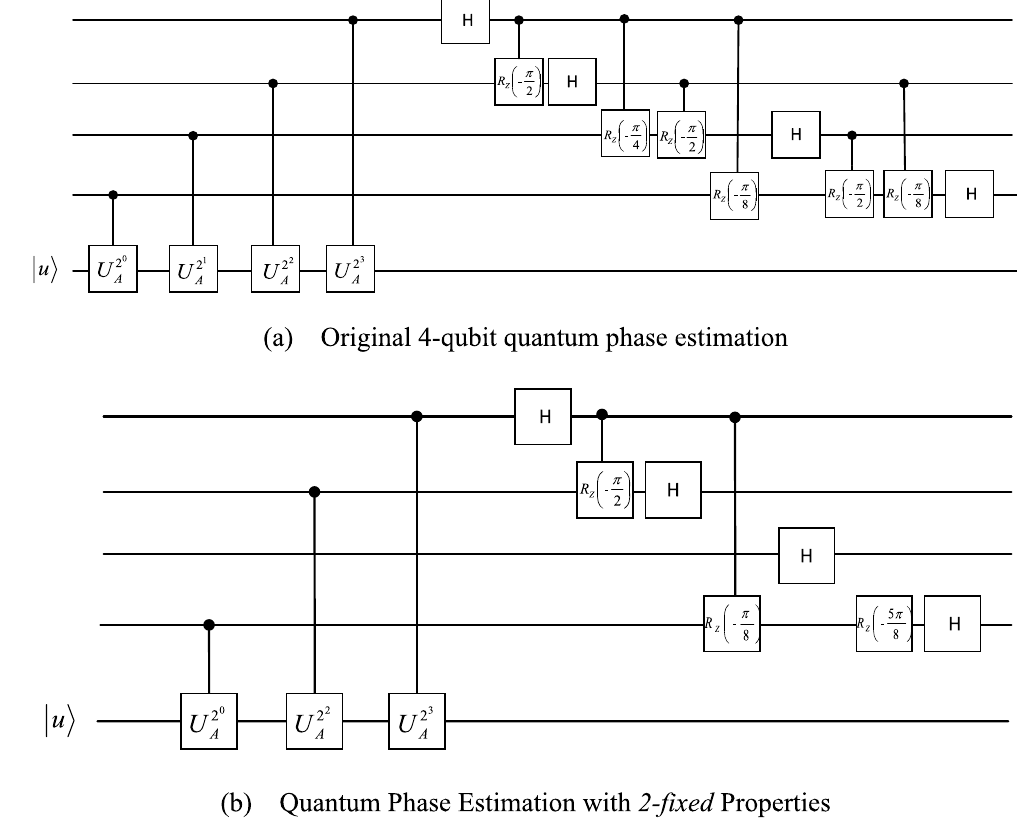
Figure 4. Comparison of quantum phase estimation with and without 4-estimated and 2-fixed properties.